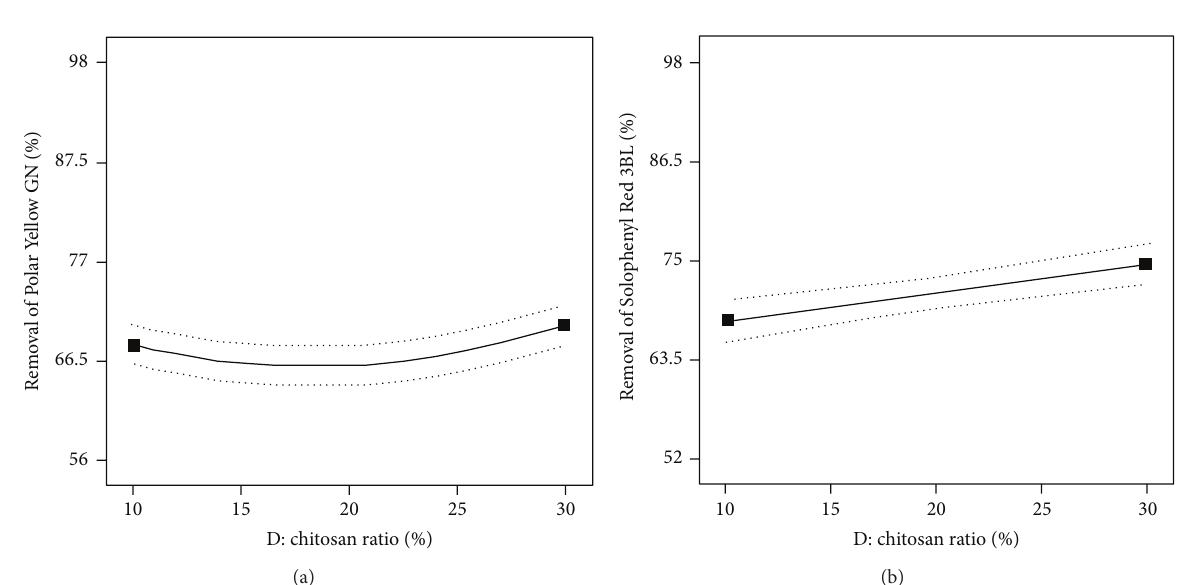
Figure 10: Effect of chitosan ratio on the removal of acidic and direct